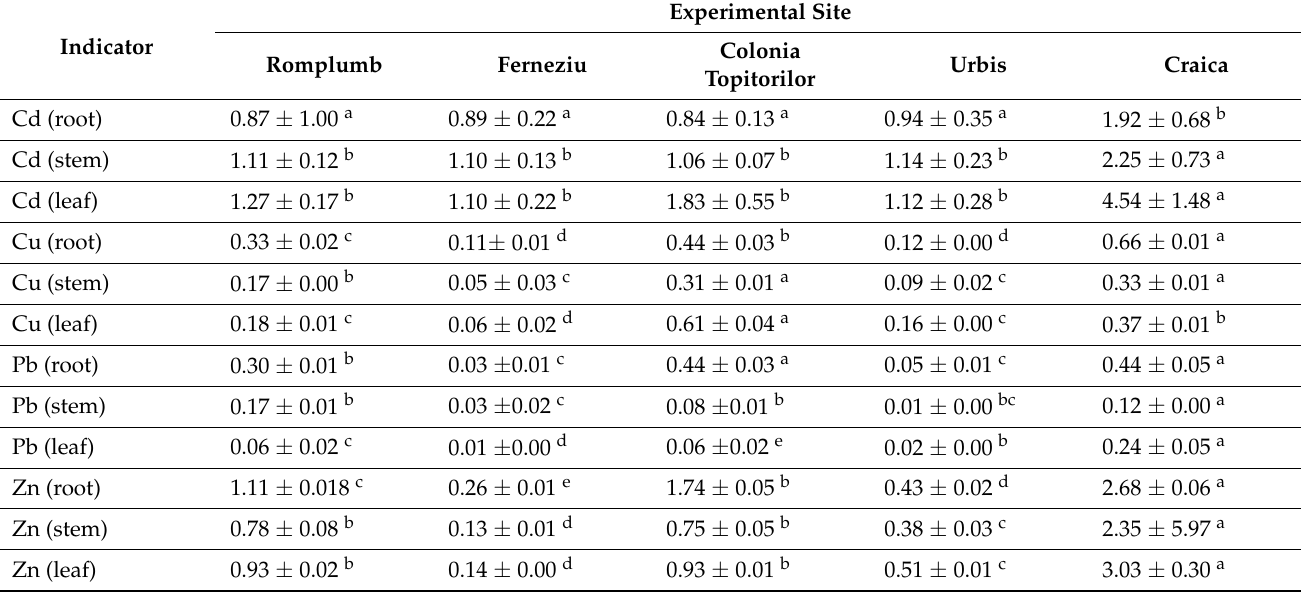
Table 5. The potential of RJ in accumulating HM (Cd, Cu, Pb and Zn) according to the